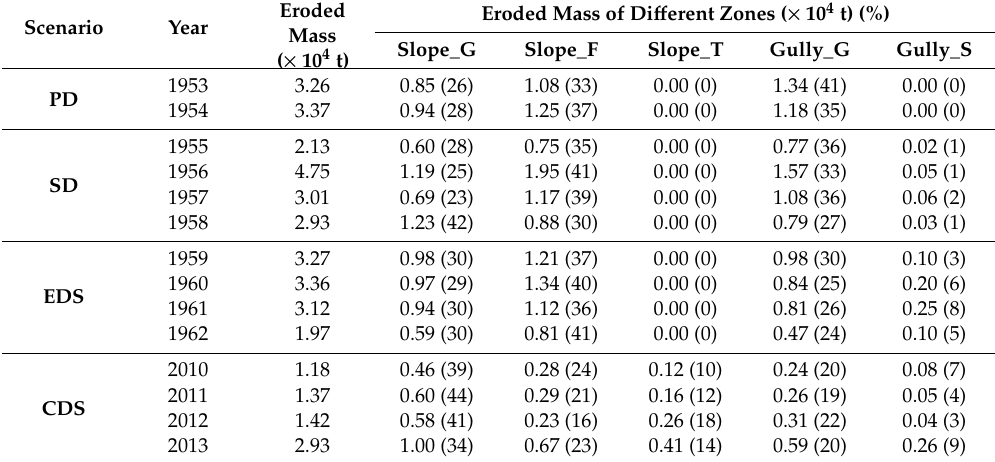
Table 8. Eroded sediment mass of the four simulation